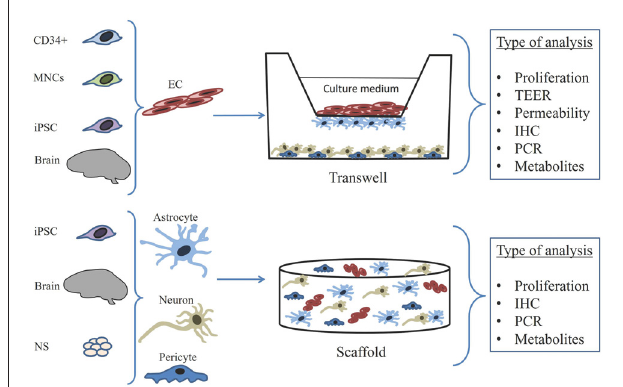
FIGURE 2 | Scheme illustrating general approaches to establishment and validation of BBB in vitro models consisted of neurovascular unit cells isolated from the whole brain or cerebral microvessels, or differentiated from stem/progenitor cells, induced pluripotent stem cells (iPSCs) and neurospheres (NS). Three major types of BBB models are shown schematically, including transwell system, 3D model. Right panel shows current opportunities in the assessment of BBB in vitro model’s integrity and functional competence. TEER, transendothelial electric resistance; NS, neurosphere; MNCs, bone marrow-derived mononuclear cells; EC, endothelial cells; IHC,